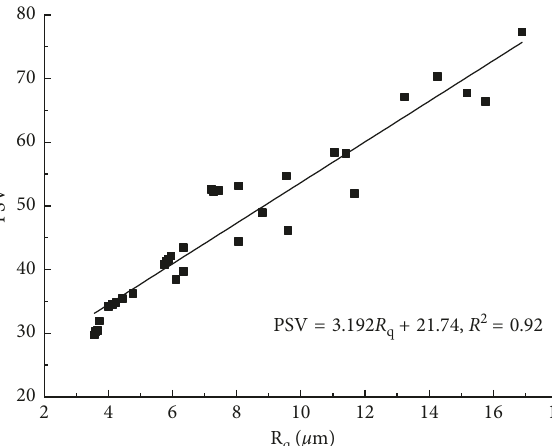
Figure 15: Correlation between PSV and R